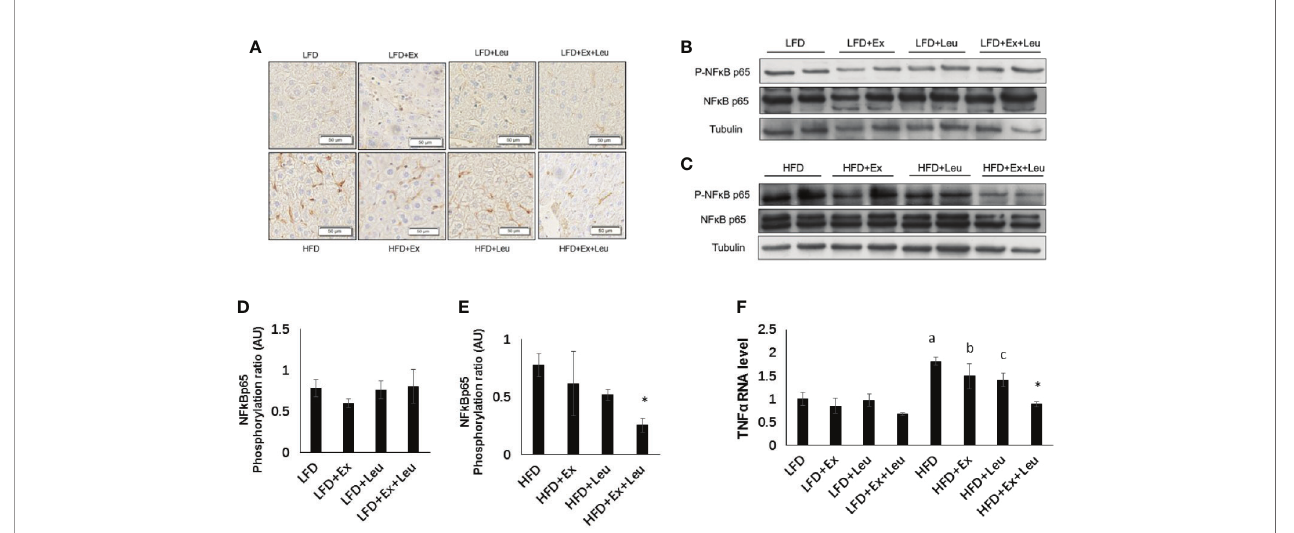
FIGURE 5 | The intervention of exercise and leucine reduced liver in fl ammation under HFD. C57BL/6J male mice of 5 – 6 weeks were fed with LFD or HFD. Leucine with a concentration of 1.5% and/or moderate intensity exercise was added in the 10th week and administrated for 4 weeks. (A) Macrophage in fi ltration in the liver. The sections of liver were immunostained for F4/80. For (B, C) , the levels and phosphorylation states of NF- k B p65 were determined using western blots. For (D, E) , quanti fi cation of in fl ammatory signaling (arbitrary units) for (B, C) , respectively. (F) Changes in liver mRNA level of TNF a under LFD or HFD using RT-PCR. The data are mean ± s.d. (error bars), n = 6 mice per group. *p < 0.05, HFD versus HFD + Ex + Leu; a, p < 0.01, LFD versus HFD; b, p < 0.05, LFD + Ex versus HFD + Ex; c, p = 0.053, LFD + Leu versus HFD +